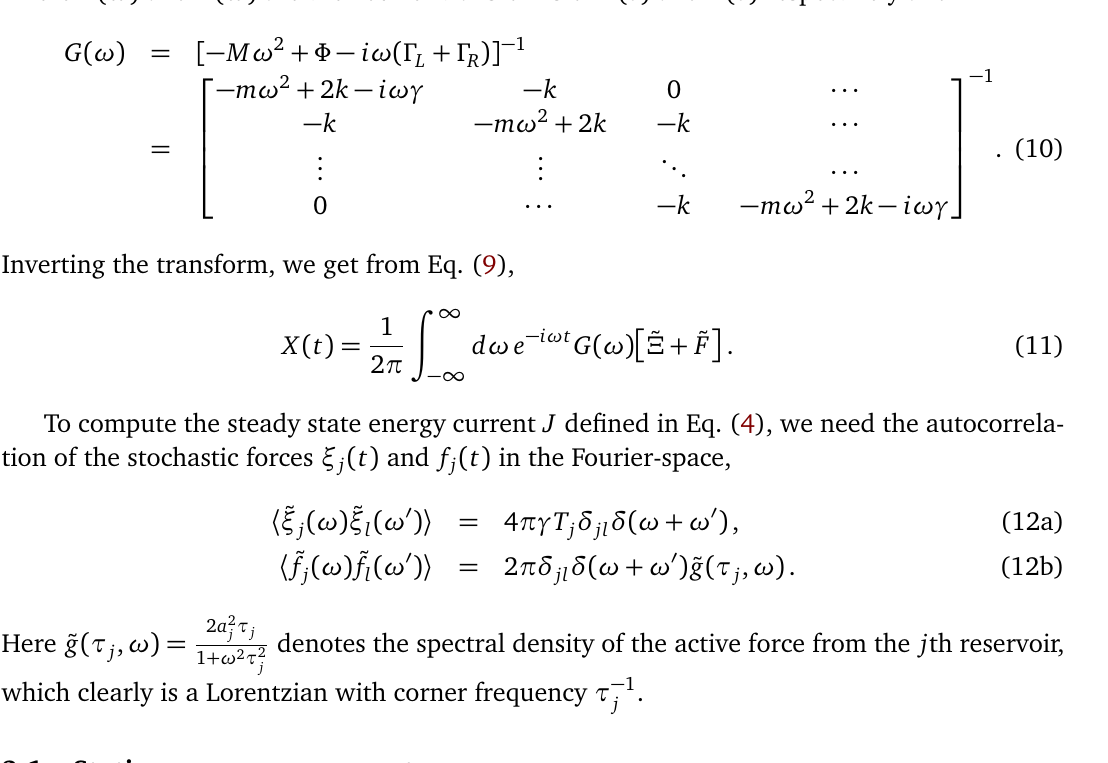
vs τ Figure 2: Activity induced current J for different values of τ act 1 γ = 1 = m = a = a and k = 2; symbols indicate the data obtained from nu- N 1 merical simulations with N = 64 oscillators and the solid black lines indicate the analytical prediction Eq. (6). The red crosses mark the non-trivial current reversal points and τ indicates the value of the activity for J is m act